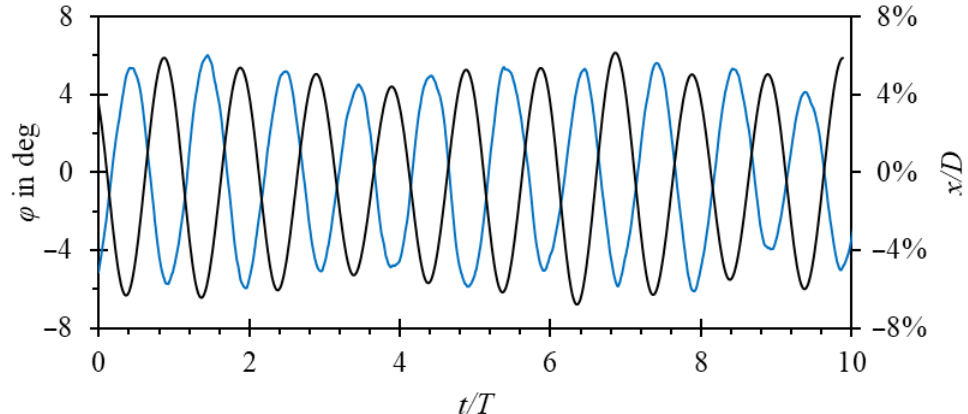
Figure 18. Position of the oscillator vs. time for q v = 40 m 3 /h. Black line—three-dimensional numerical model, blue line—experiments. Series are offset by 0,5 T intentionally, for clarity reasons.